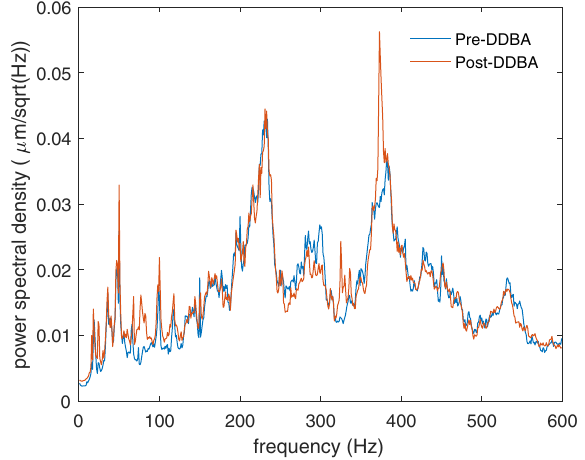
FIG. 15. Vertical power spectral density normalized to β ¼ 1 . 5 m. The spectrum remains largely unchanged in shape, y with new features appearing around 75 Hz, 325 Hz and 375 Hz.